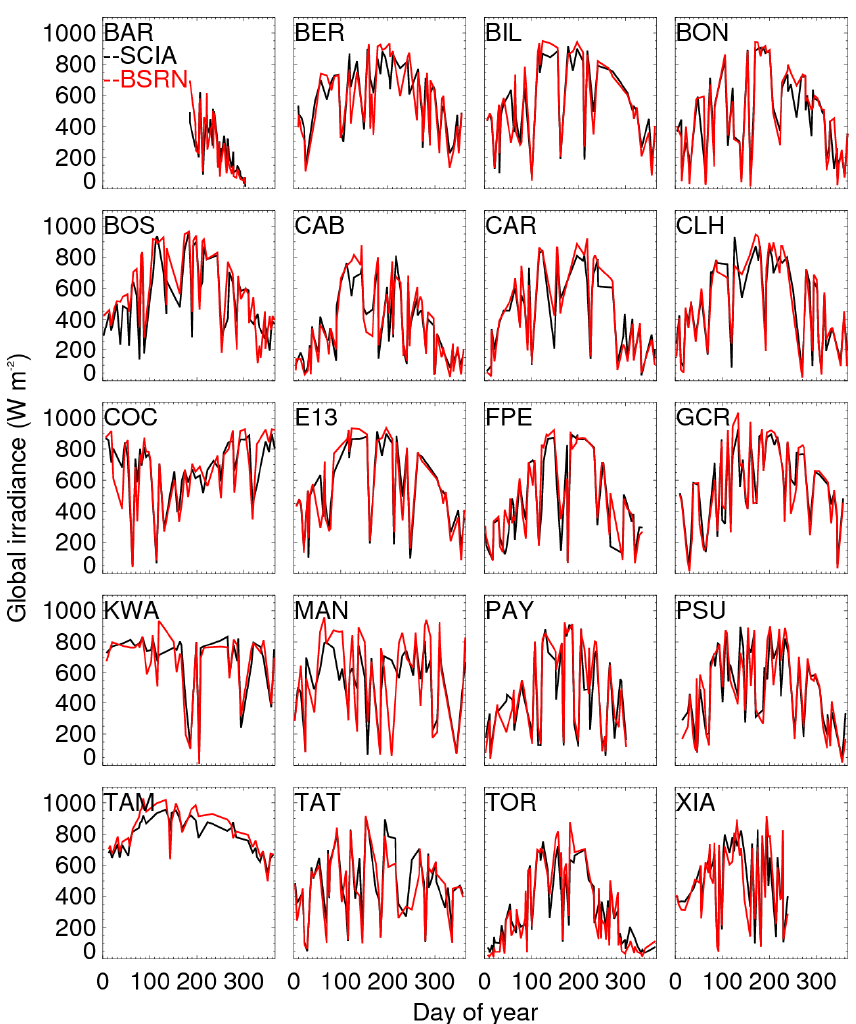
Fig. 5. Instantaneous surface solar irradiances derived from SCIAMACHY (black line) and the hourly mean BSRN global irradiances (red line) as a function of day of year for every station. The cases are from January to December 2008, except for BAR, PAY, XIA.